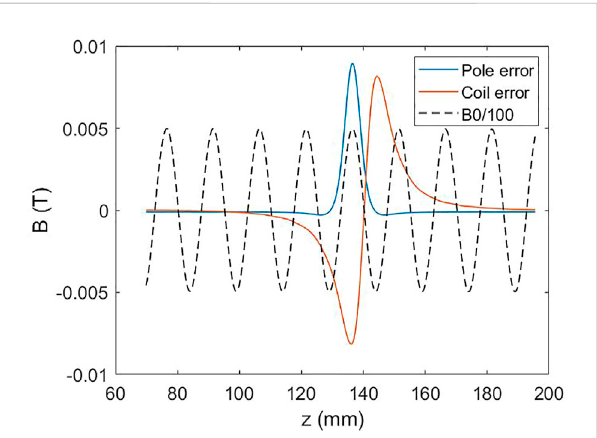
FIGURE 4 Field deviation caused by 0.2 mm displacement of a single pole and a single coil bundle. The black dashed curve indicates the ideal fi eld whose amplitude was reduced to